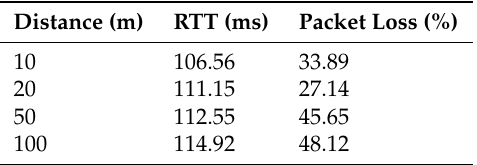
Table 4. Round time trip (RTT) and packet